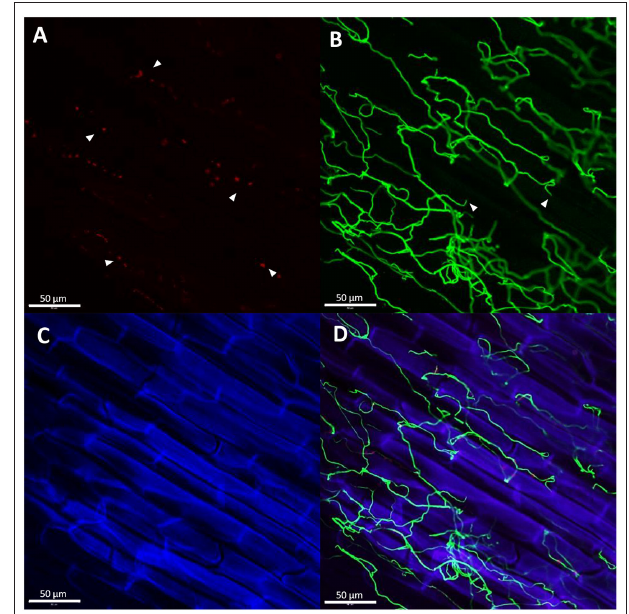
FIGURE 7 | Metarhizium anisopliae F672 hyphae growing on 1-month old maize roots. The presence of glycoproteins, α -mannopyranosyl, and/or α - glucopyranosyl residues, around hyphal adhesion sites were stained with ConA-AF633. These sites indicate the hyphal penetration points through the root cell wall visualized as red dots [ (A) , arrowheads). The net of hyphae growing around and inside the root cell stained with WGA-AF488 are visualized in green (B) . The constriction zones in the hypha also confirm the vegetal cell wall penetration points [ (B) , arrowheads]. The root cells were stained with propidium iodide visualized in blue (C) . Overlay of the three previous images (D) . Images were taken with a confocal microscope (LSM 510 META–Zeiss) using the program ZEN 2009. The bar represents 50 µ